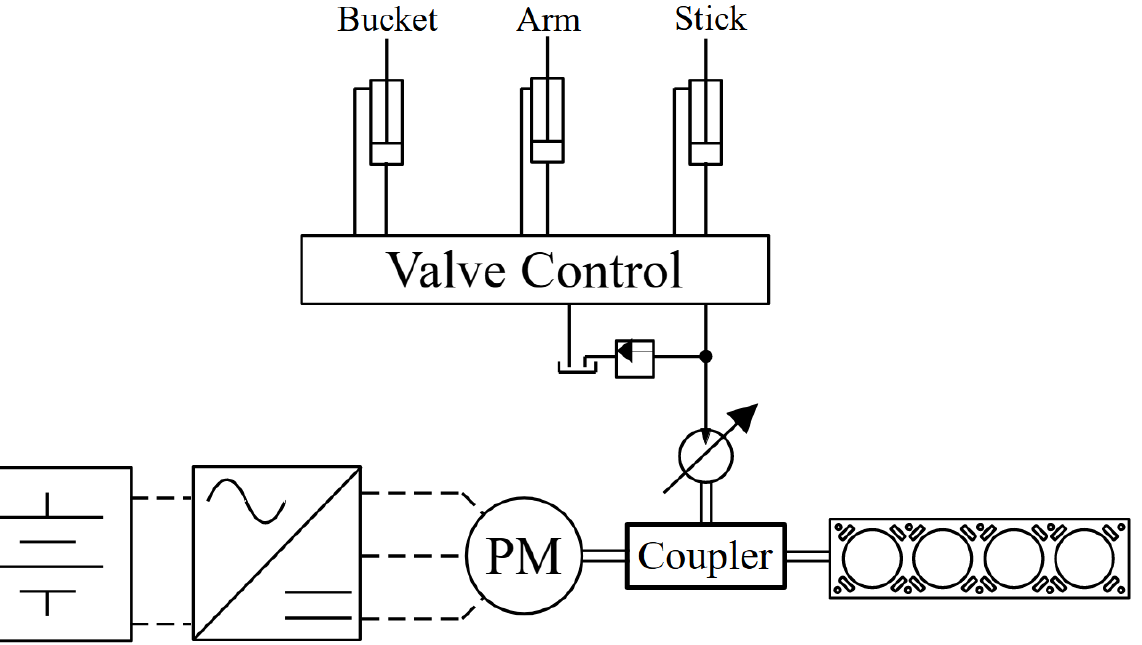
Figure 2. Parallel configuration applied to the implements of a